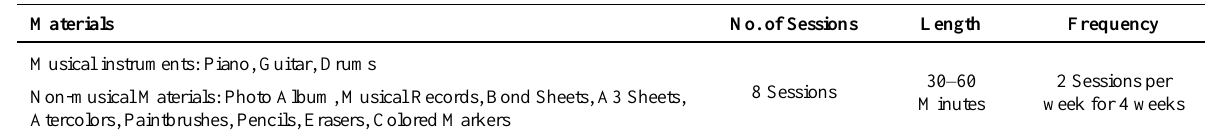
Table 2. Description of the material used throughout the intervention, the number of sessions held, the approximate length of time, and the frequency of